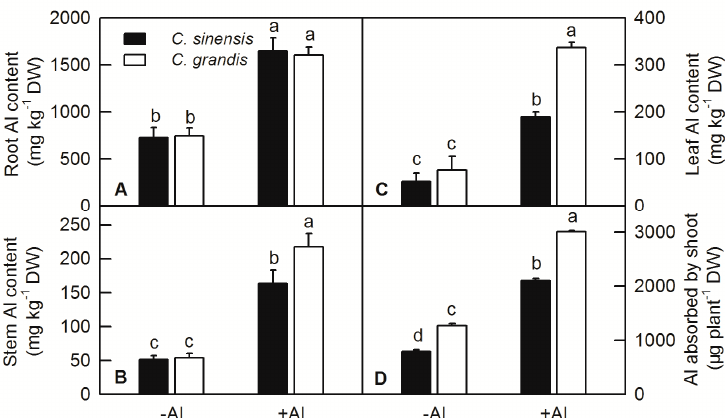
Figure 2. Effects of Al toxicity on Al content in root ( A ), stem ( B ), leaf ( C ) and Al absorbed by shoot ( D ) of C. sinensis and C. grandis . Bars represent means ± SD ( n = 4). Different letters above the bars indicate a significant difference at p < 0.05.